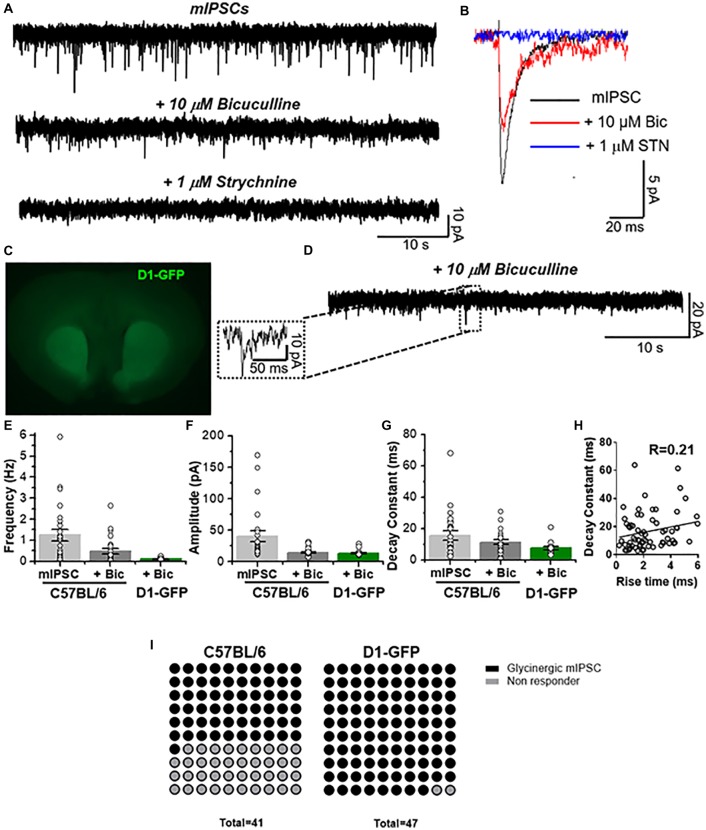
Presence of glycinergic transmission in medium spiny neurons (MSNs). (A) Representative synaptic current traces from C57BL/6J mice showing the total miniature inhibitory postsynaptic currents (mIPSC) and the pharmacologically isolated glycinergic mIPSC (recorded in presence of TTX (500 nM), bicuculline (10 μM), CNQX (10 μM) and D-APV (50 μM)) and glycinergic mIPSC blocked by 1 μM strychnine (STN). (B) Average traces of mIPSC (black line), glycinergic mIPSC (red, denominated + bicuculline) and STN blocked (blue). (C) Coronal brain slice from D1-GFP mice showing the fluorescence in dorsal striatum and nucleus accumbens. (D) Representative synaptic traces from a D1 MSN showing glycinergic mIPSCs recorded in presence of TTX (500 nM), bicuculline (10 μM), CNQX (10 μM) and D-APV (50 μM). (E–G) The graphs summarize synaptic event properties of frequency (E), amplitude (F) and decay constant (G) from mIPSCs and glycinergic synaptic current in accumbal neurons from C57 and D1-GFP mice. (H) The graph shows the relation between rise time constant (10%–90%) vs. decay time constant (10%–90%) of glycinergic synaptic events obtained from 4 D1 MSNs. No correlation was found (R = 0.21, Spearman’s correlation rank test: p = 0.0727). Data are mean ± SEM (n = 25 C57, n = 15 D1-GFP). (I) Dot plots summarize the MSNs that have glycinergic synaptic currents and those where no currents were present. GlyR-mediated synaptic currents were found in 61% of MSNs from C57BL/6 mice and in 98% of MSNs from D1-GFP mice.